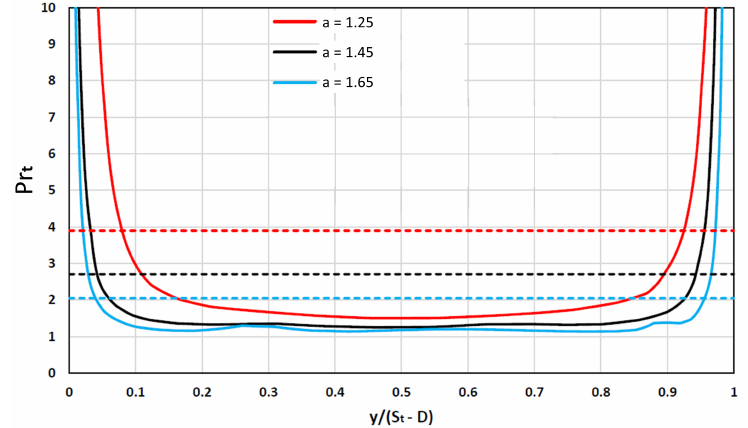
Figure 9. Turbulent Prandtl number distribution between two nearby pipes according to Equation (5) for Pe = 1350. Dashed lines mark the average value calculated between 0.05 ≤ y / ( S T − D ) ≤ 0.95.